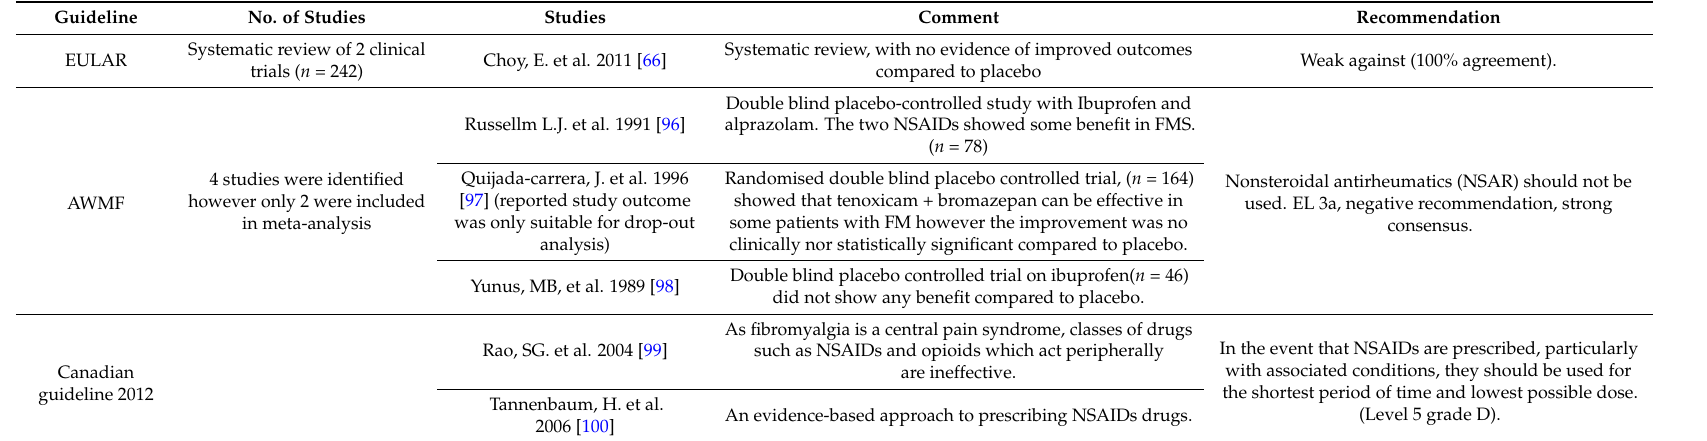
Table A7. Non Steroidal Anti-Inflammatory Drugs